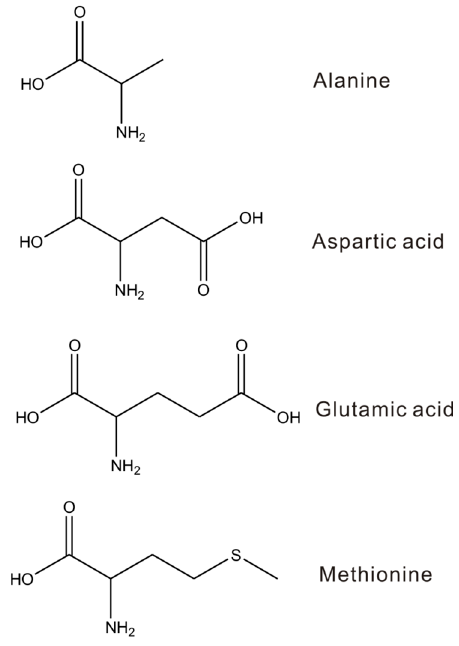
Figure 1. Molecular structures of alanine, aspartic acid, glutamic acid, and methionine.